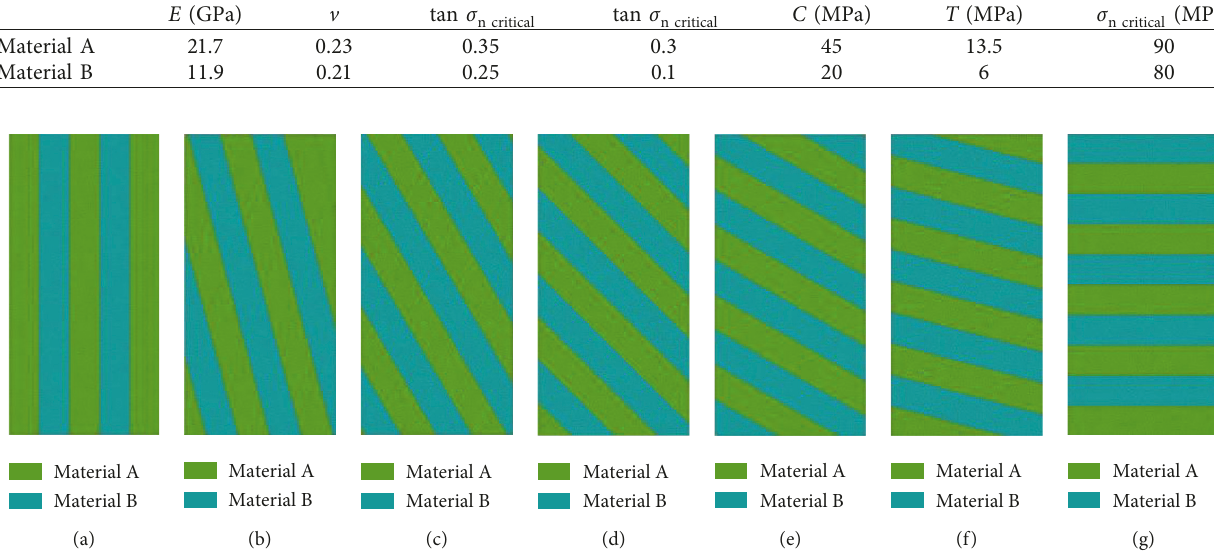
0 ° ; (b) α 15 ° ; (c) α (cid:29) (cid:29)